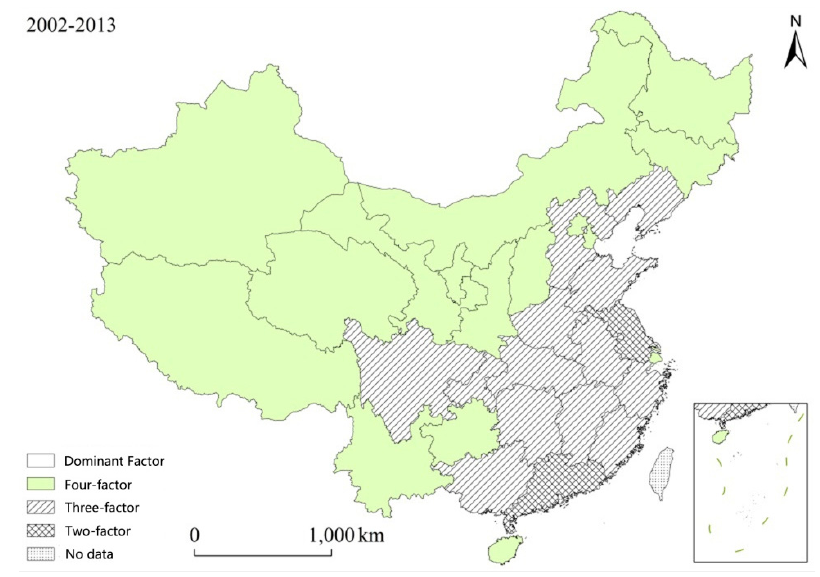
Figure 7. Types of the main driving factors of the wastewater discharge in China.